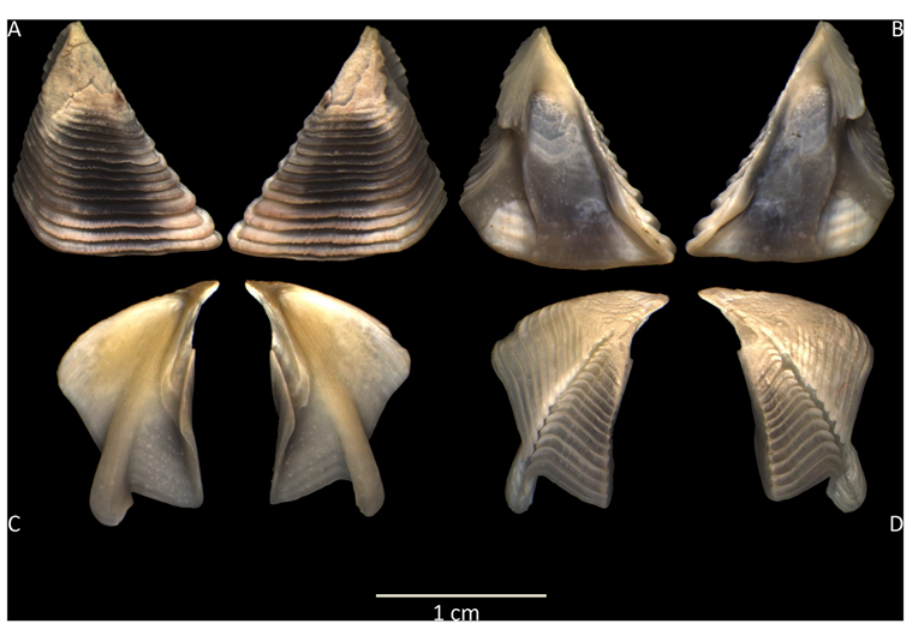
Fig 2. View of terga. Exterior (A) and interior (B) views of scuta and exterior (D) and interior (C) view of terga from a Megabalanus azoricus individual sampled in the Azorean archipelago (Terceira